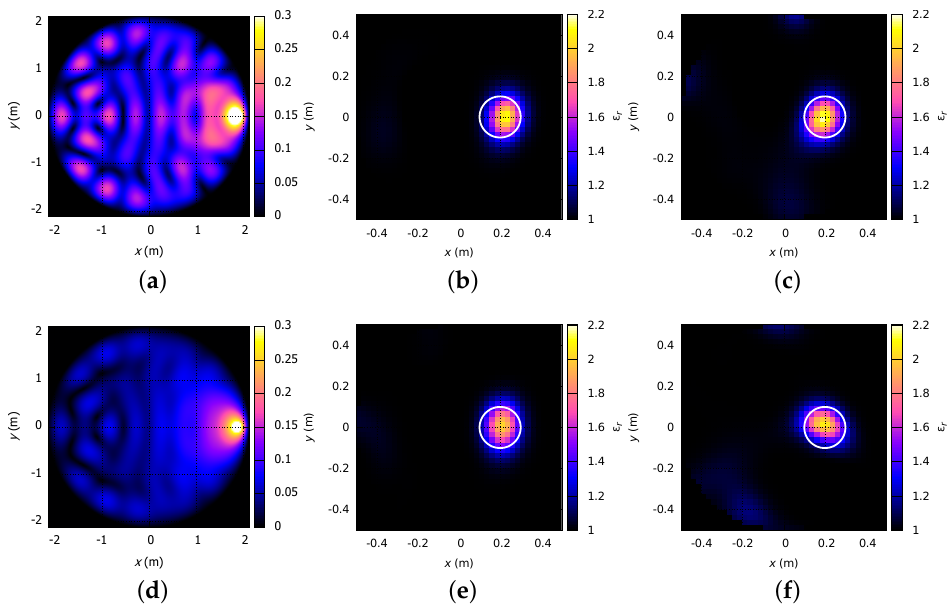
Figure 9. Examples of Green’s functions and reconstructed distributions of the relative dielectric permittivity with small conducting enclosure, a = 2.125 λ . Upper row: results with σ b = 1 mS/m: ( a ) Green’s function magnitude for a source at ( ρ s ,0 ) ; ( b ) Reconstruction with cylindrical enclosure; ( c ) Reconstruction in free space. Lower row: results with σ b = 2 mS/m: ( d ) Green’s function for point source located at ( ρ s ,0 ) ; ( e ) Reconstruction with cylindrical enclosure; ( f ) Reconstruction in free space.